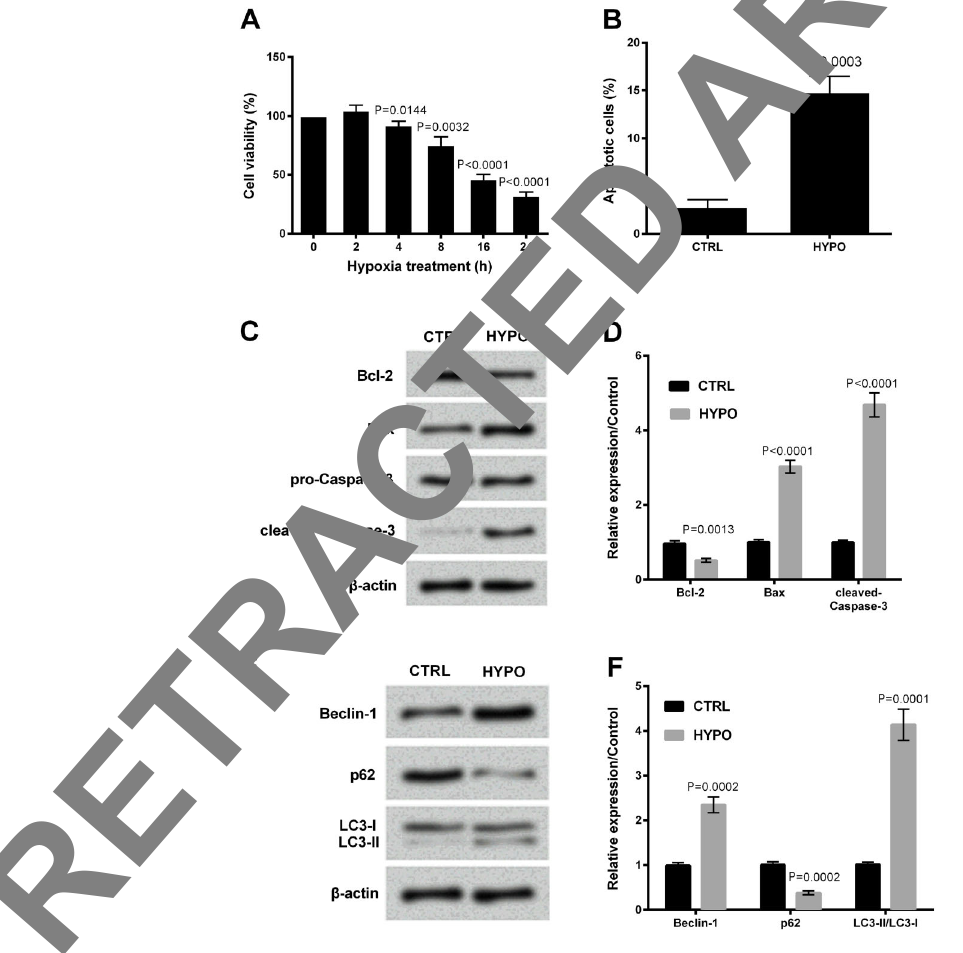
Figure 1. Hypoxia (HYPO) triggered damage of H9c2 cells. A , Cell viability was detected by CCK-8 assay. B , Cell apoptosis was assessed by fl ow cytometry. C and D , Protein expression levels of Bcl-2, Bax, pro-caspase-3, cleaved-caspase-3, and b -actin, and ( E and F ) of Beclin-1, p62, LC-3-II, LC-I, and b -actin were measured by western blot assay. Data are reported as mean ± SD (ANOVA or Student ’ s t